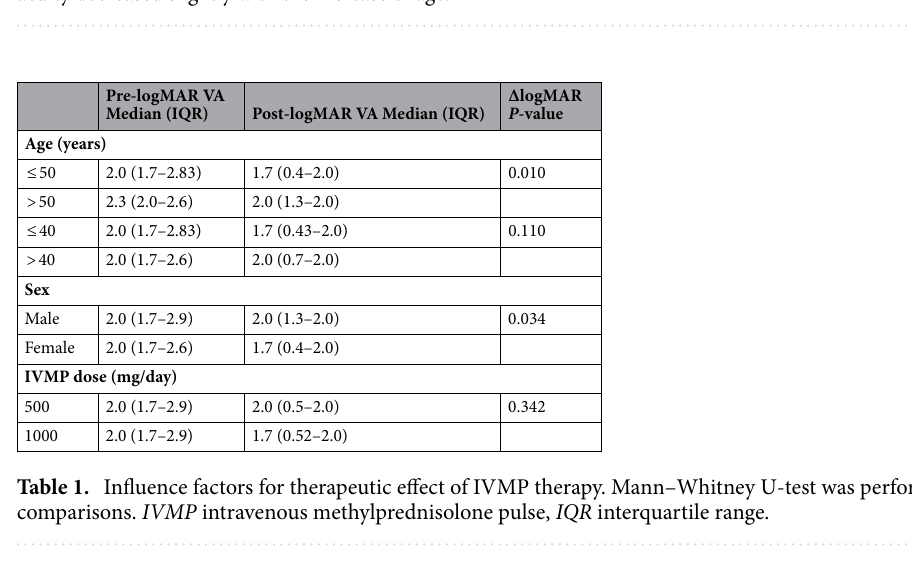
(Table 2). On analysing correlations based on another classification method (replacement of NLP, LP, HM, and FC categories with VA logMAR = 3.0, 2.7, 2.3, and 1.85, respectively) 11 , we obtained the same results as above.